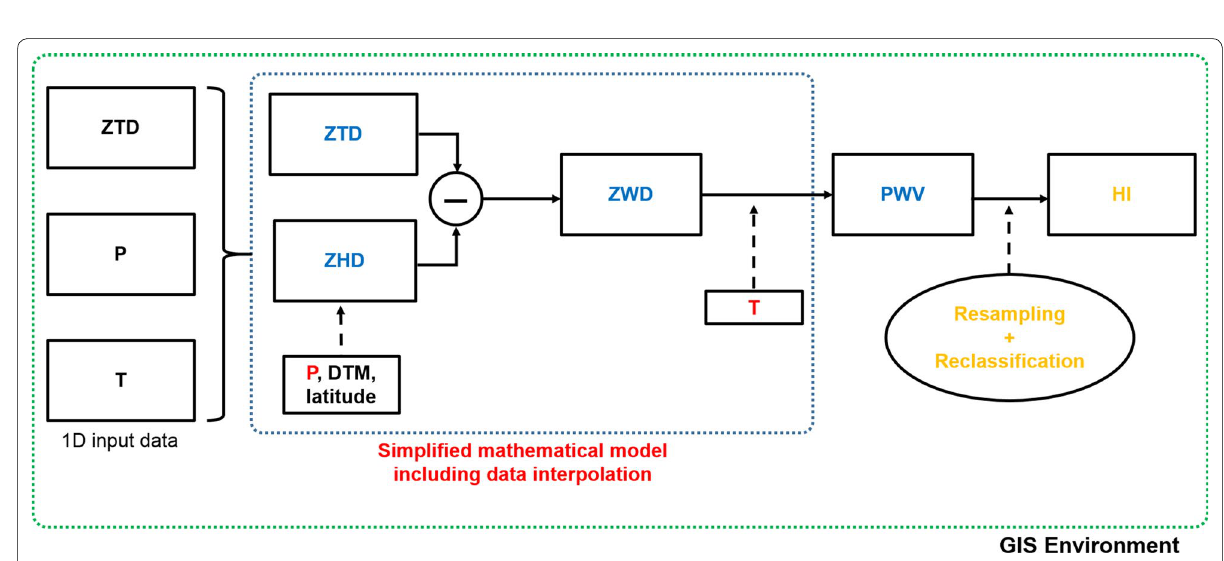
Fig. 3 Scheme of the G4M